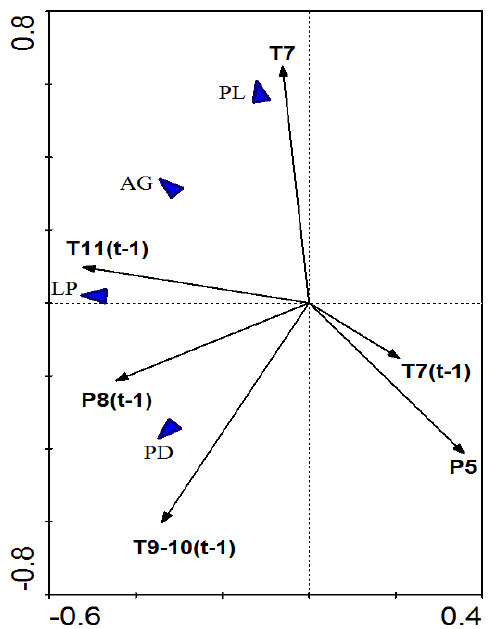
Figure 5. The redundancy analysis between two residual chronologies and the climatic factors. Only significant climate factors ( p < 0.05) are presented. The longer the vector of the climate factor, the greater the contribution. The shorter perpendicular line between the chronology point and the climatic vector (itself, or the extension line) indicates a higher correlation between them. Chronology and vectors pointing in the same direction means a positive correlation, and vice versa. P represents precipitation; T represents mean temperature; t-1 represents the previous year , the num−ber indicates the month. PL indicates the residual chronology of P. likiangensis ; AG indicates the residual chronology of A. georgei ; PD indicates the residual chronology of P. densata ; LP indicates the residual chronology of L. potaninii .